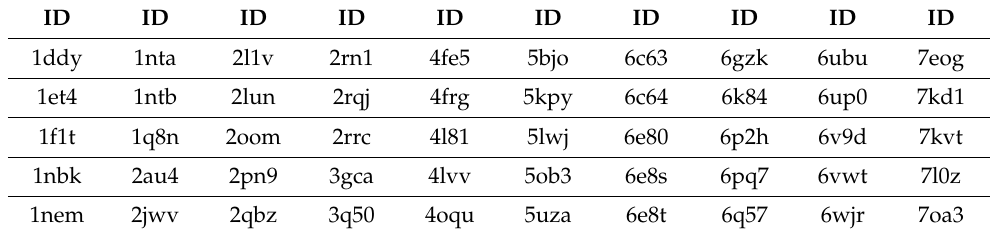
Table 1. List of used PDB